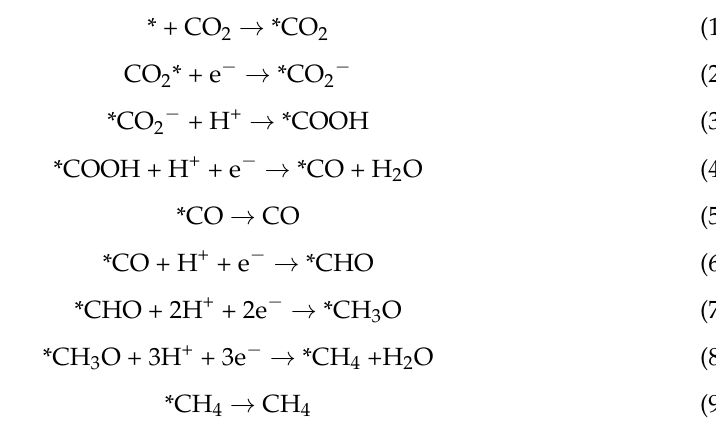
2 reduction process on CuAu-SnIn 4 S 8